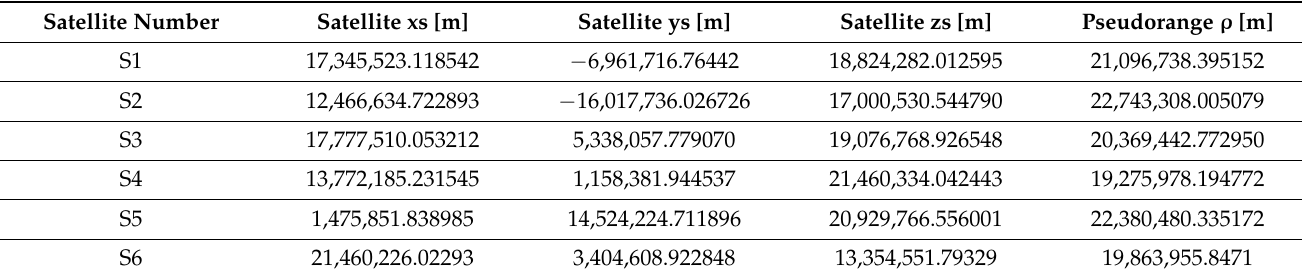
Table 1. Satellite coordinates and pseudoranges.